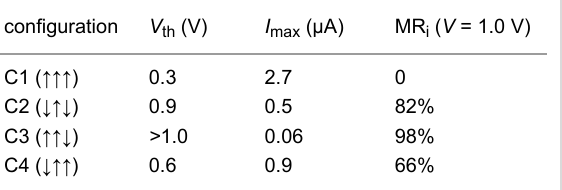
Table 1: Threshold voltage ( V th ), maximum current for bias voltage in [0,1] V ( I max ), and multi-state magnetoresistance (MR) at a bias voltage of 1 V for the different magnetization configurations. Repro- duced with permission from [32], copyright 2014 AIP Publishing.